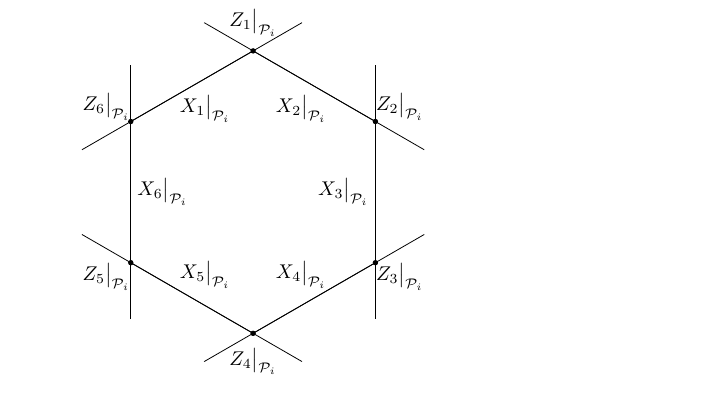
Figure 14 . Three sets of region momentum variables for the atlas in table 1.